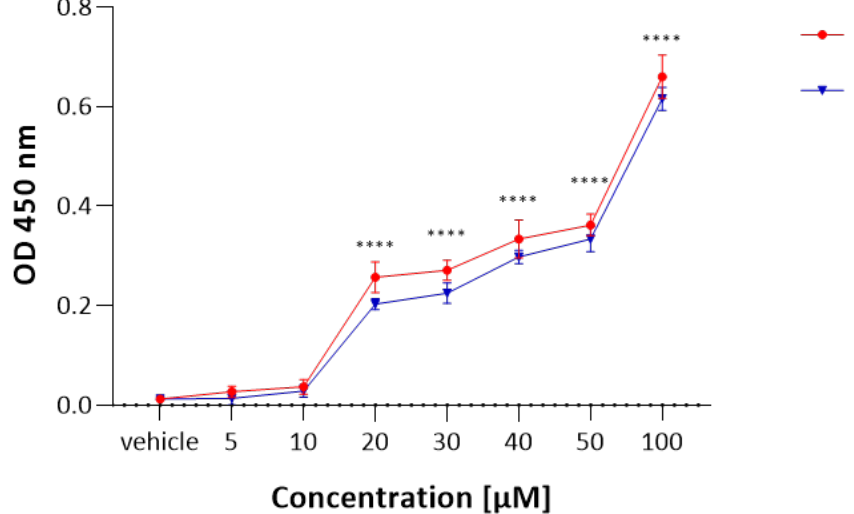
Figure 2. The influence of BE and BA on Vero cell viability measured by LDH assay. Data are shown as means ± SD; **** p < 0.0001 vs. vehicle; Dunnett’s test.